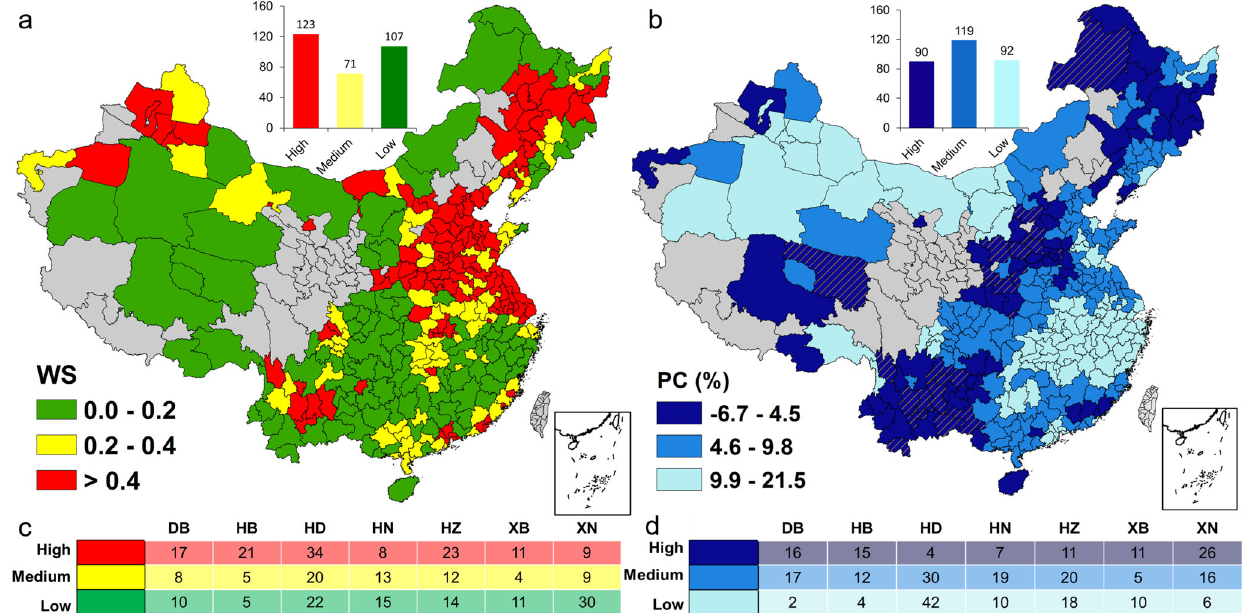
Fig. 1 Water scarcity and climate sensitivity of prefectures across China. a Water scarcity index (WS) derived from water demand to water availability (WA) of each prefecture. The WS classes were de fi ned based on the WS values following ref. 10 low (<0.2), medium (0.2 – 0.4), and high ( ≥ 0.4). b Precipitation change (PC) (precipitation reduction) that caused a 25% reduction of WA. A lower PC indicates a higher sensitivity of WA to precipitation change (climate change). Values plotted on the color scales are categorized into three groups following ref. 32 high ( ≤ PC 30 , dark blue), medium (between PC 30 and PC 70 , blue), and low ( ≥ PC 70 , shallow blue), in which PC i represents the i th percentile of PC values. Shaded prefectures are ones with positive precipitation changes (negative precipitation reduction) that would still lead to WA reduction. c WS distribution and d PC distribution across districts of China. DB, HB, HD, HN, HZ, XB, and XN are abbreviations of different districts and the full description are shown in Supplementary Fig. 1. Gray-shaded prefectures are excluded from this